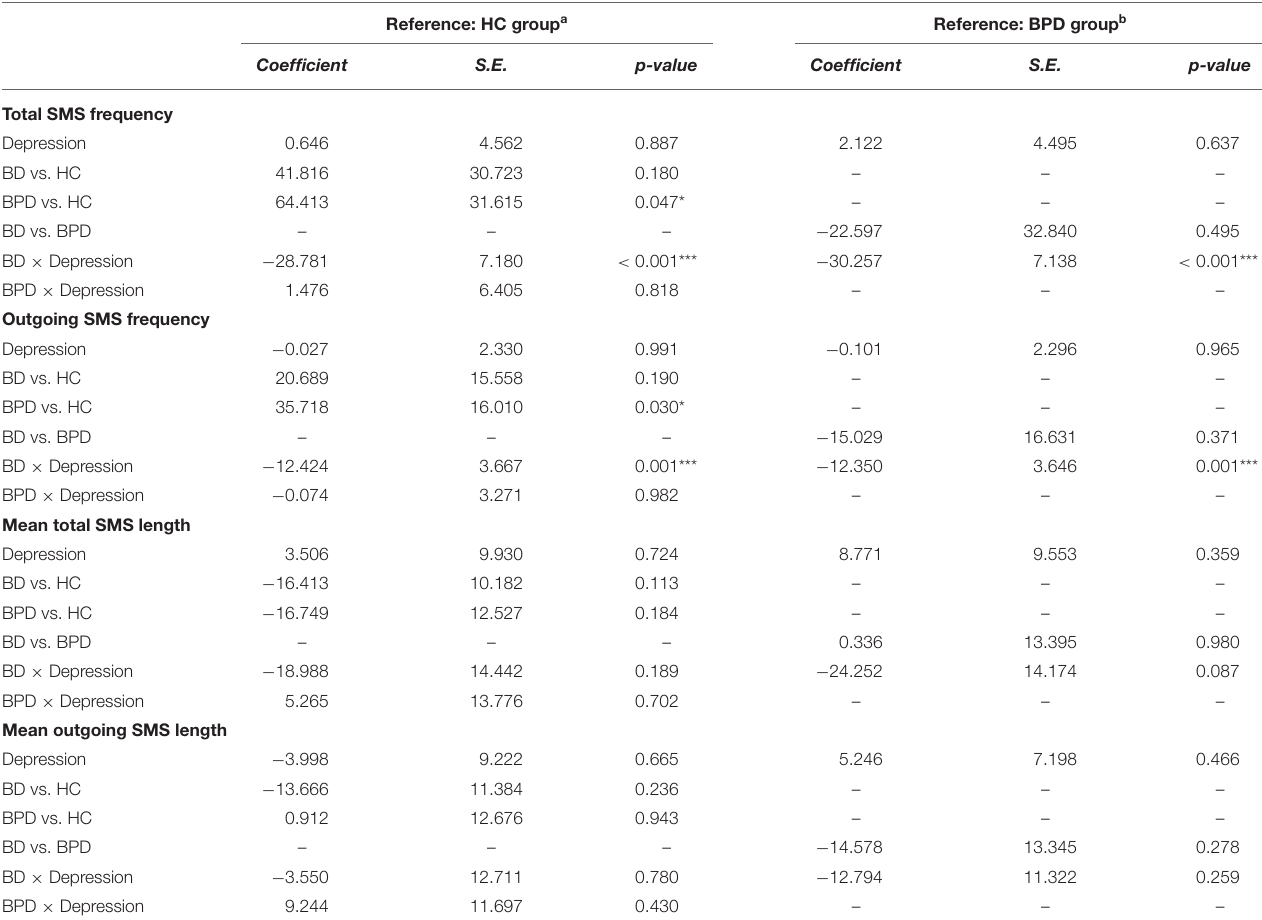
TABLE 7 | SMS data by diagnosis & mood state interaction